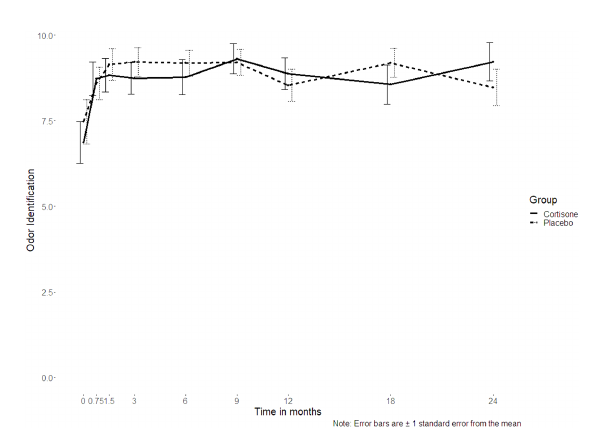
FIGURE 5 Line plot of the 16-item odor identi fi cation test scores assessed using Snif fi n ’ Sticks over the 2-year follow-up showing no interaction between the steroid and the placebo group (p=0.380); the dotted line represents the placebo group, the continuous line represents the steroid